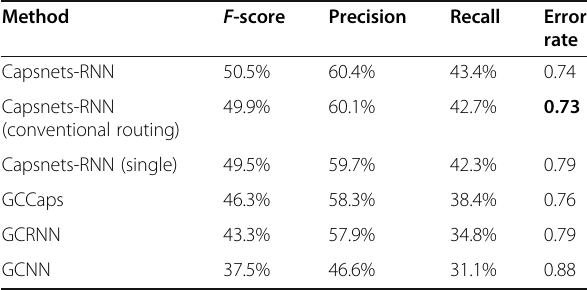
Table 5 Performance results of sound event detection subtask